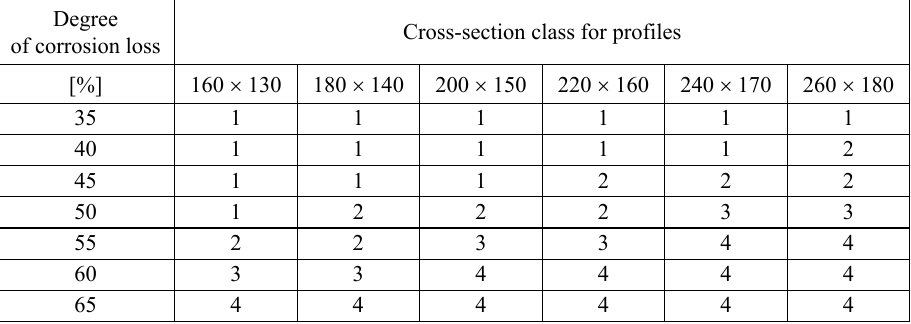
Table 1. Cross-section class by degree of corrosion